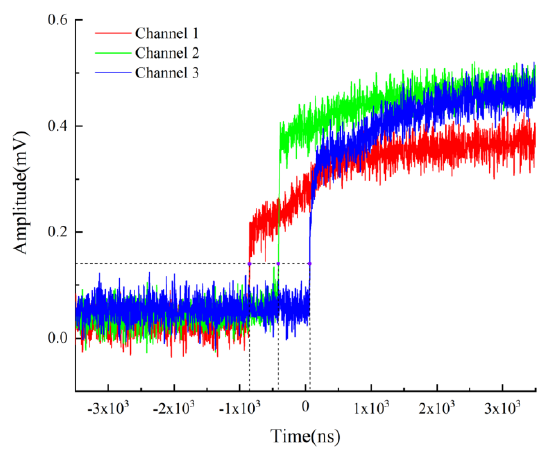
Figure 10. Typical output signal of the oscilloscope.